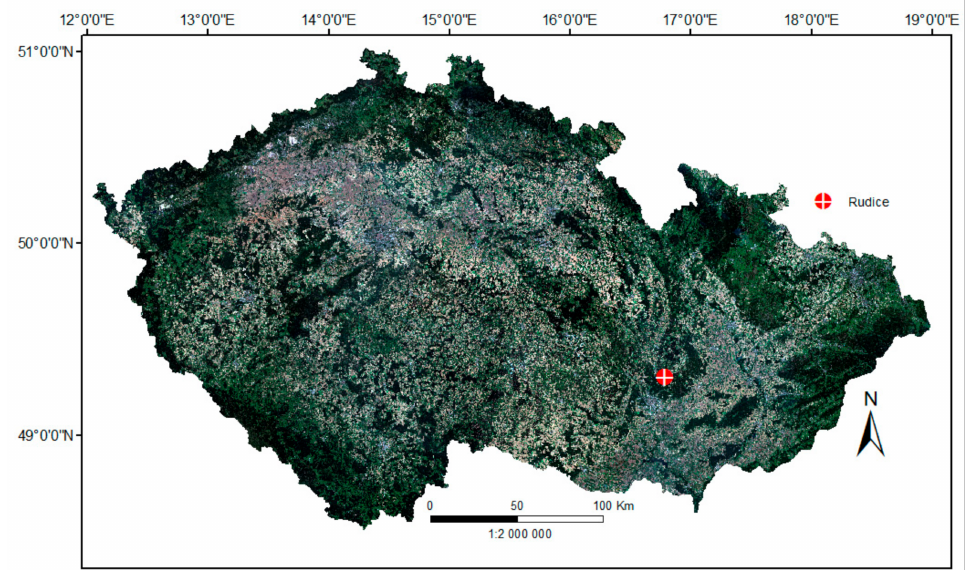
Figure 1. Location of Rudice in the Czech Republic (imagery: